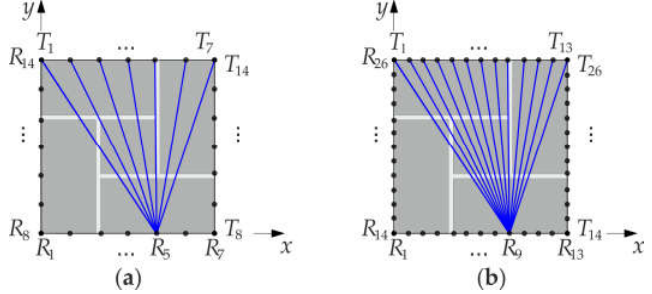
Figure 5. Configuration of the measurement points: ( a ) configuration #A (transmission of waves at points T 1 - T 14 and sensing of waves at points R 1 - R 14 ), ( b ) configuration #B (transmission of waves at points T 1 - T 26 and sensing of waves at points R 1 - R 26 ).